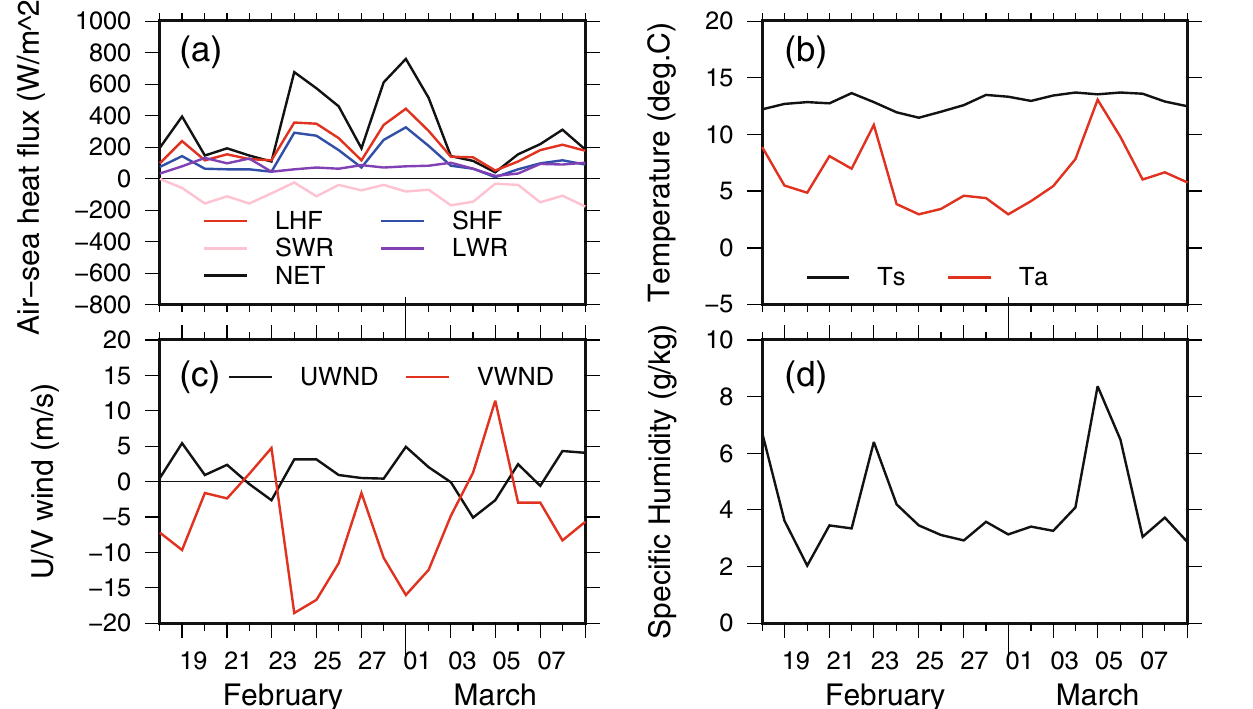
Figure 2. Typical daily time series of surface heat fluxes and related physical parameters observed at JKEO from 18 February to 8 March 2007 (30 days). LHF, SHF, SWR, LWR, and NET indicate the surface latent heat flux, sensible heat flux, net shortwave radiation, net longwave radiation, and net heat flux, respectively. T s , T a , UWND, and VWND are the sea surface temperature, air temperature, zonal components, and meridional components of surface winds, respectively. Full time series of JKEO and KEO are shown in Supplementary Figs. S1 and S2,